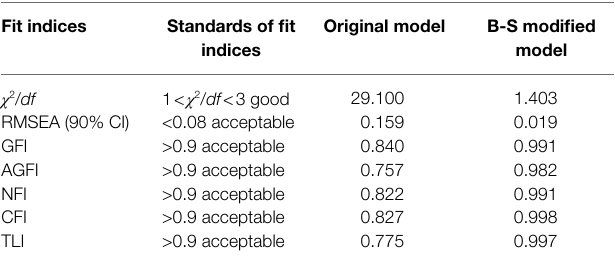
TABLE 6 | Results for SEM fit.